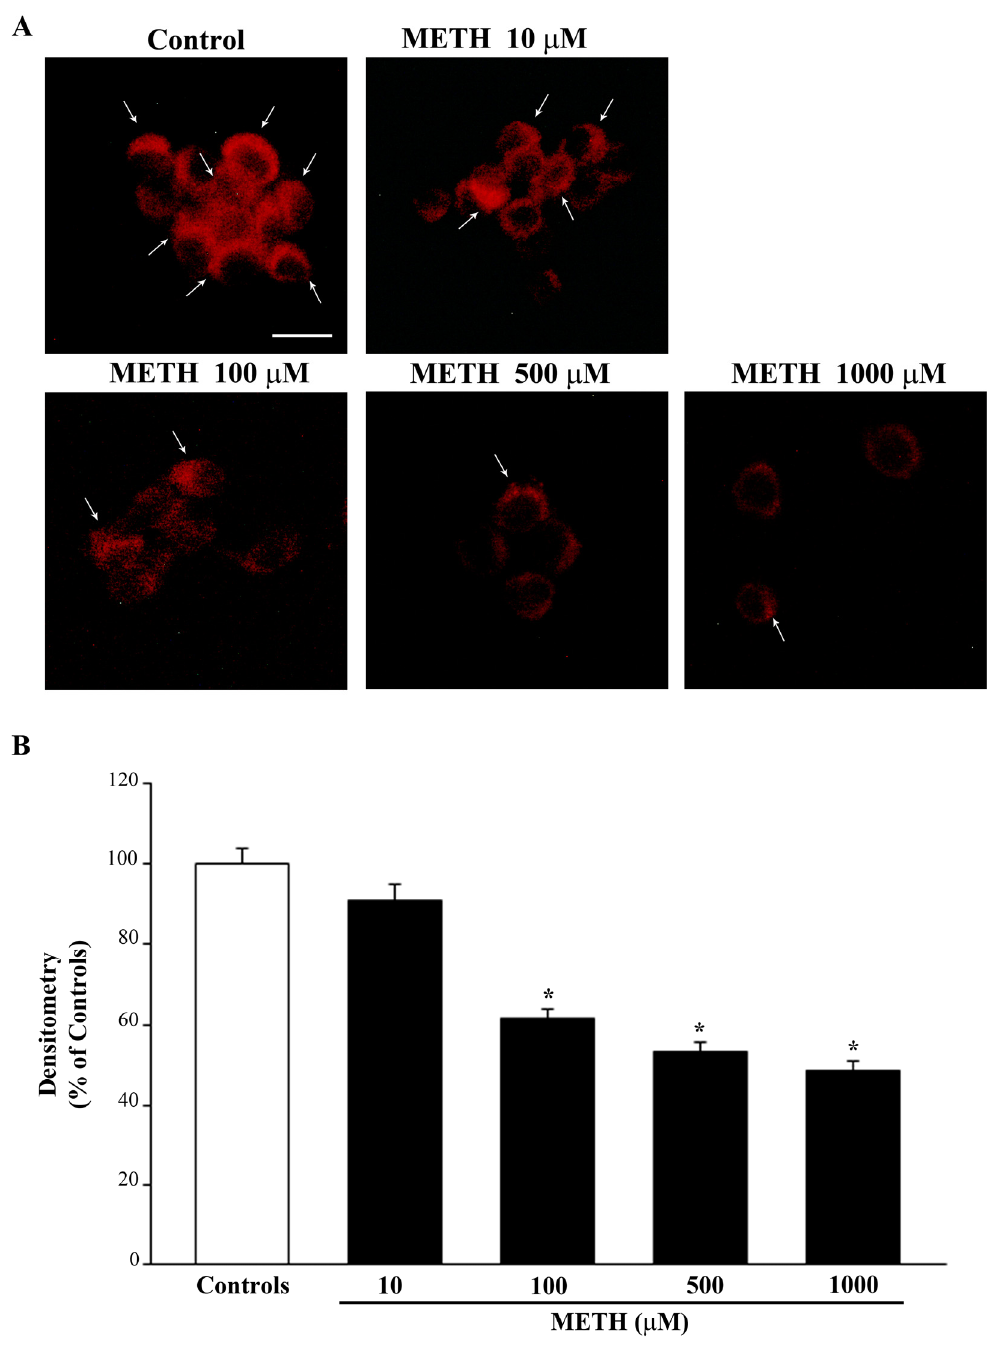
Figure 4. METH dose-dependently reduces MTR-R fluorescence. MTR-R labels healthy mitochondria. ( A ) Representative pictures showing a dose-dependent decrease of MTR-R fluorescence for doses starting at METH 100 µ M. Arrows indicate intensely MTR-R-stained cells. ( B ) The graph reports the mean densitometry of MTR-R fluorescence per cell. Values are given as the mean percentage ± S.E.M. of optical density (assuming controls as 100%) from three independent experiments. * p < 0.05 compared with controls. Scale bar = 11 µ